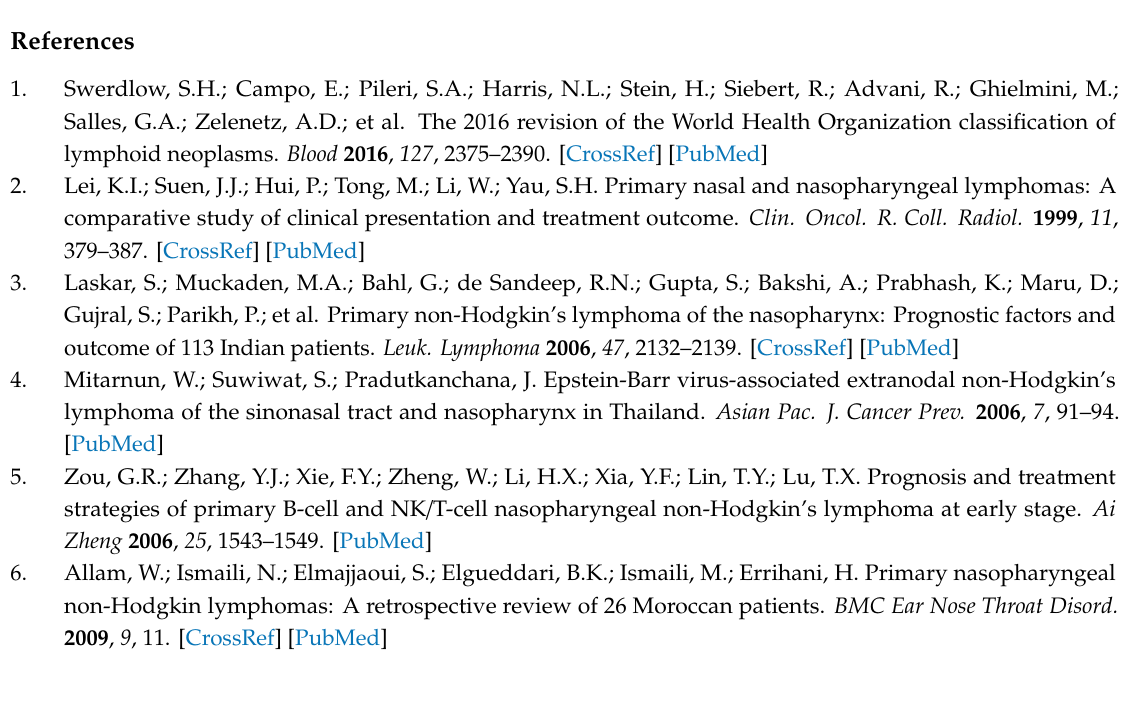
Table S1: Characteristics of stage IV NP lymphoma patients; Table S2: IHC and subtypes of NP DLBCL